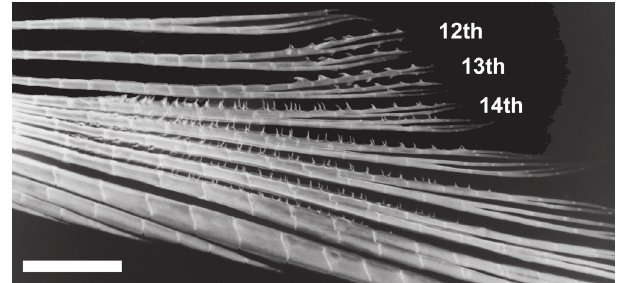
Fig. 4. Macropsobrycon uruguayanae , mature male, MCP 20900, 34.2 mm SL, left side lateral view of the caudal-fin lower lobe, hook distribution. Scale bar = 1 mm.